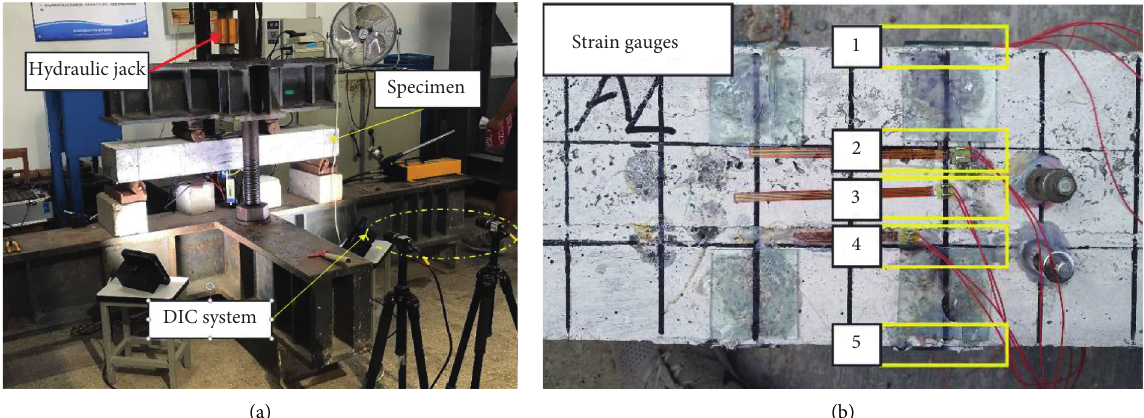
Figure 6: Experimental setup. (a) Four-point loading. (b) Strain gauges.